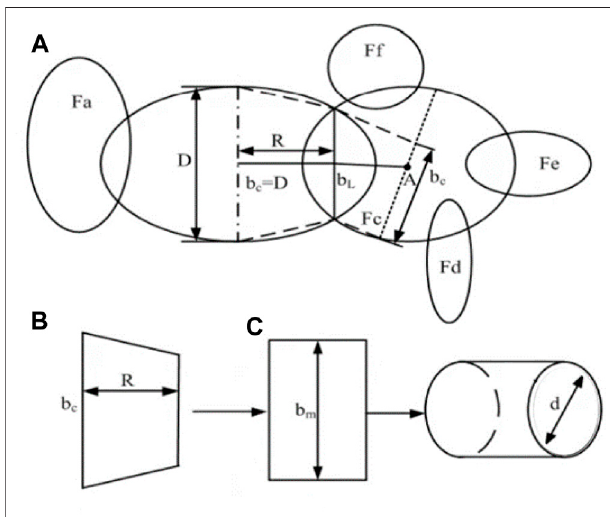
FIGURE 7 | Simpli fi ed diagram of pipe element.